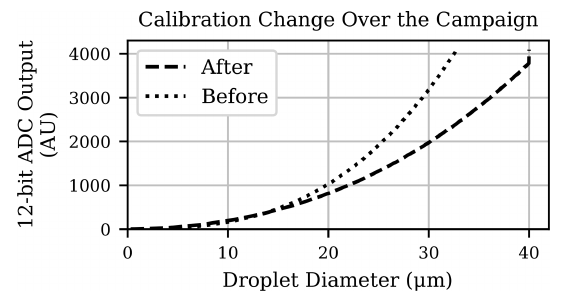
Figure 15. A correlation plot of the absolute difference in measured number concentration between the FMI-Talon and Static UCASS units, and PRY variation, for the whole campaign. The linear re- gression line and “ p ” value are